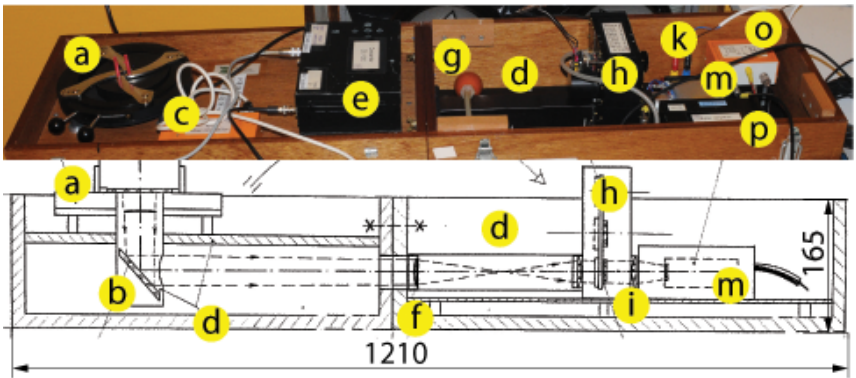
Fig. 1. The Lindau Calibration Photometer built by W. Barke and Hans Lauche at Max Planck Institute for Aeronomy, Katlenburg-Lindau (1984). (a) centering device for source under measurement (b) deflecting mirror, (c) power supply for pulse amplifier, (d) collimators, (e) HV supply. (f) objective lens, (g) dehumidifier, (h) filter wheel, (i) field stop, (k) Peltier cooler connector, (m) PMT Hamamatsu R-632, (o) connection box and (p) pulse